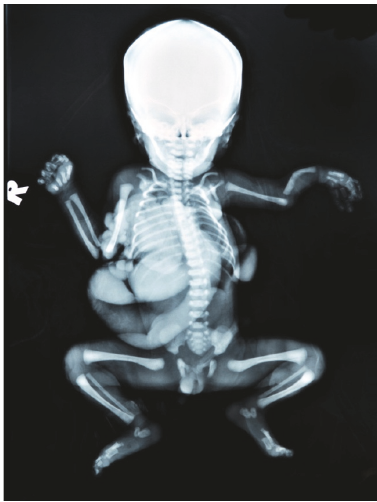
Figure 4: Skeletal